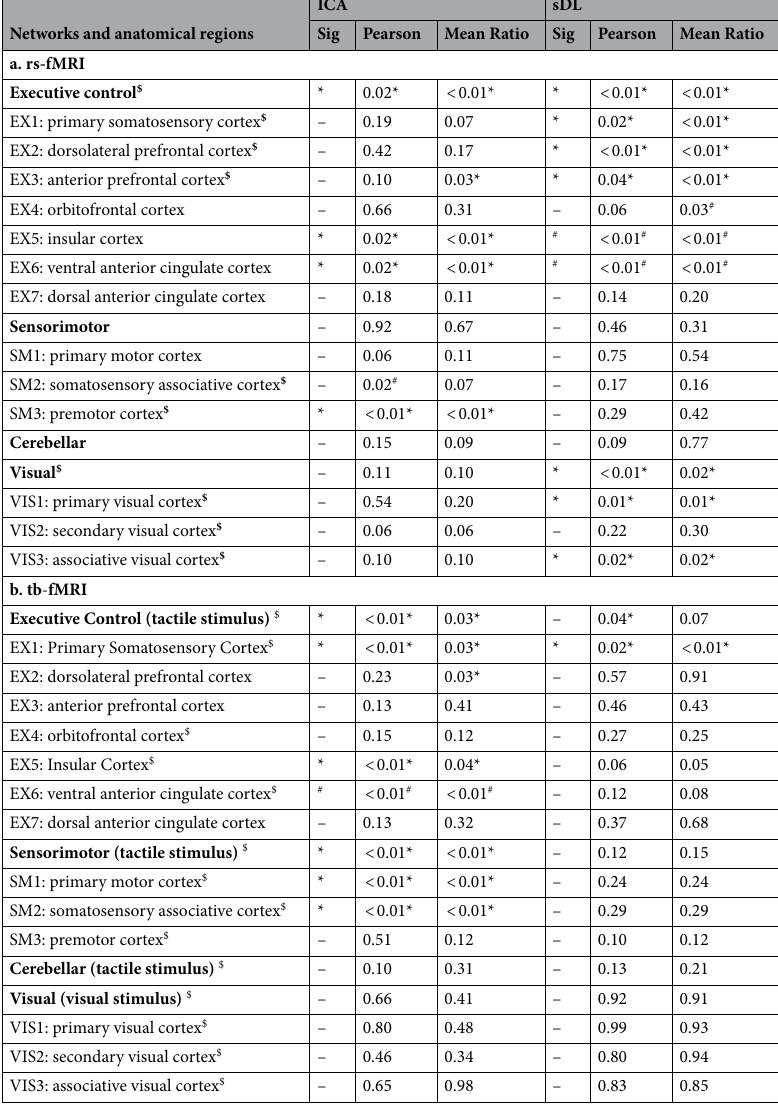
group in comparison to the control group and # for a significant increase). However, a network or anatomical region was only considered significantly different if the p-values for both the Pearson values and mean ratios were below 0.05 (‘Sig’ columns). Networks and regions that showed consistent trends across ICA and sDL